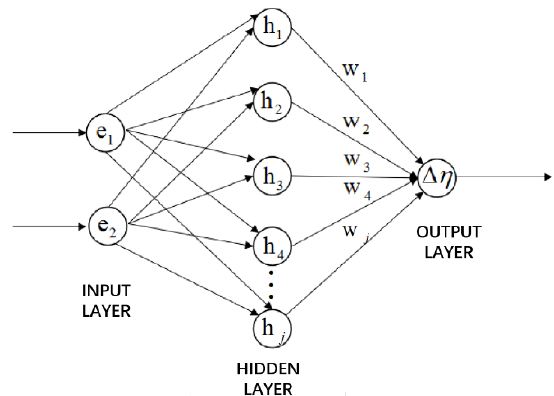
Figure 7. RBF neural network architecture diagram.